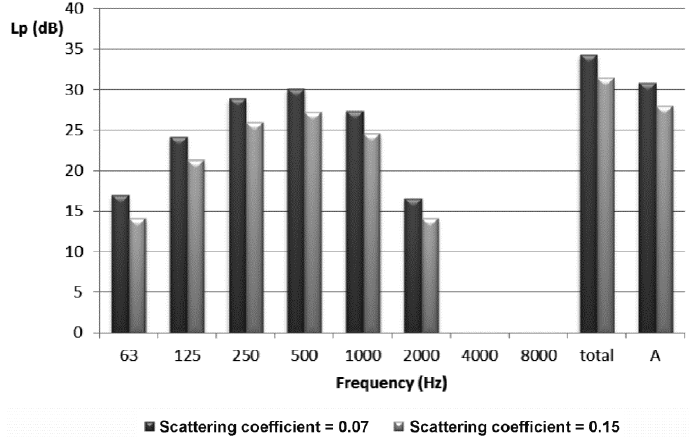
Figure 10. Comparison of the octave-band sound pressure levels with lower (0.07) and higher (0.15) scattering coefficients on Receiver 1 at the Llumeres location.